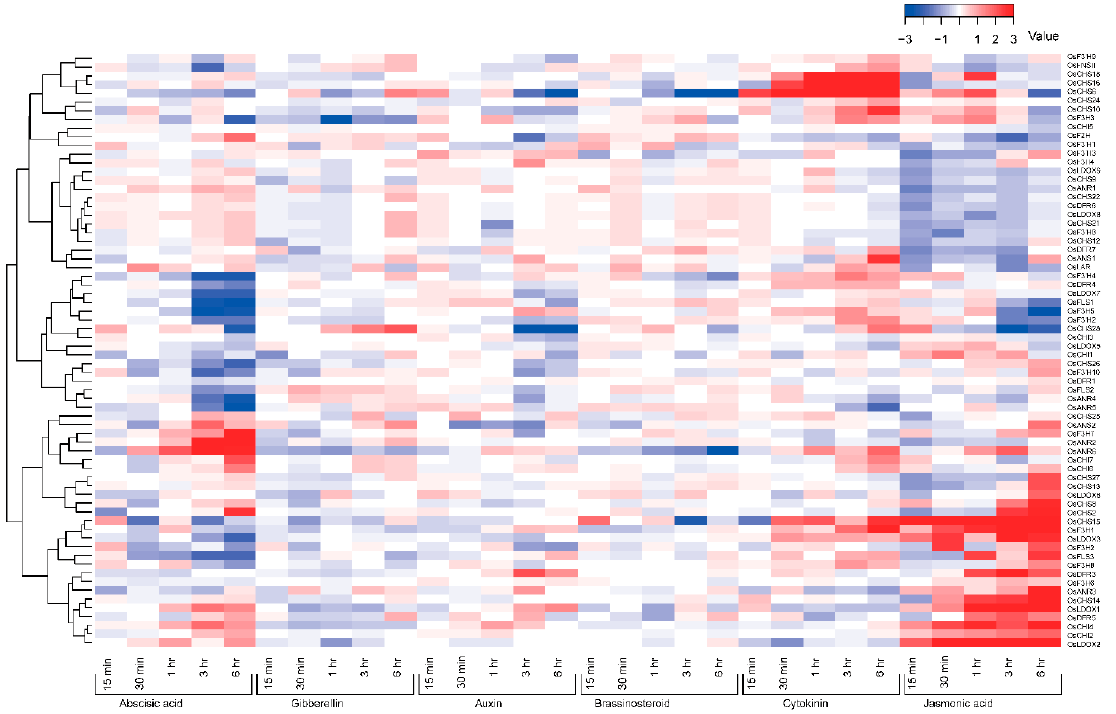
Figure 7. Expression patterns of 85 flavonoid-related genes under 6 hormone treatments: 15 min, 30 min, 1 h, 3 h and 6 h represent 15 min, 30 min, 1 h, 3 h and 6 h, respectively, after 50 µ M abscisic acid (ABA), 10 µ M gibberellin (GA), 10 µ M auxin (IAA), 1 µ M brassinosteroid (BR), 1 µ M cytokinin (CTK) or 100 µ M jasmonic acid (JA) hormone treatment. The values were calculated by the same method as those in Figure 5. Red and blue indicates upregulation and downregulation, respectively.